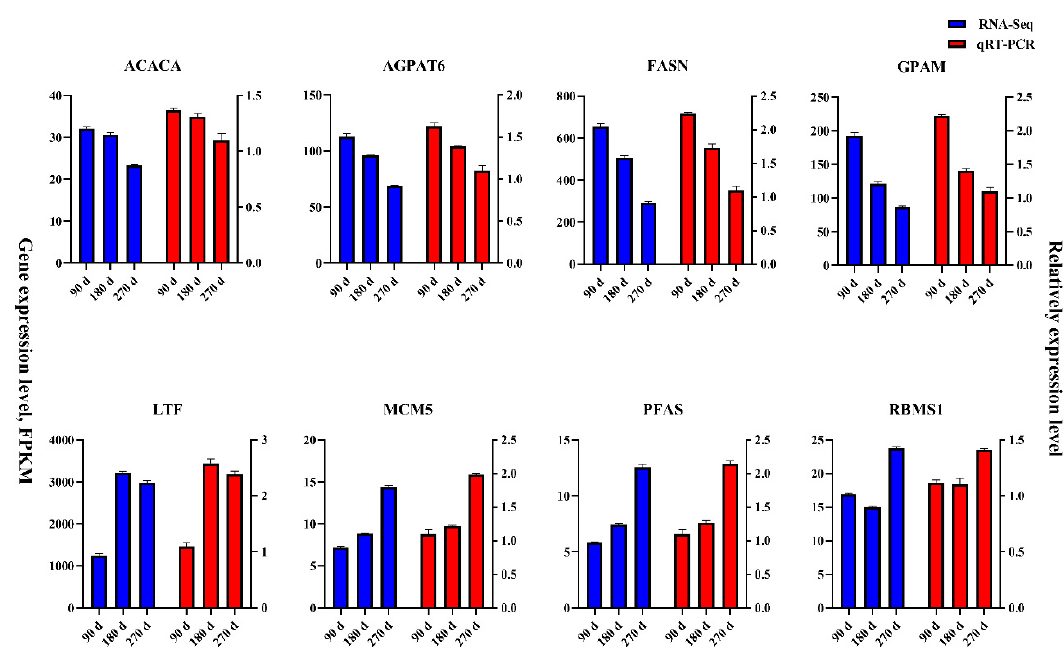
Figure 7. Expression levels of 10 differentially expressed genes detected by qRT-PCR and transcriptome sequencing.